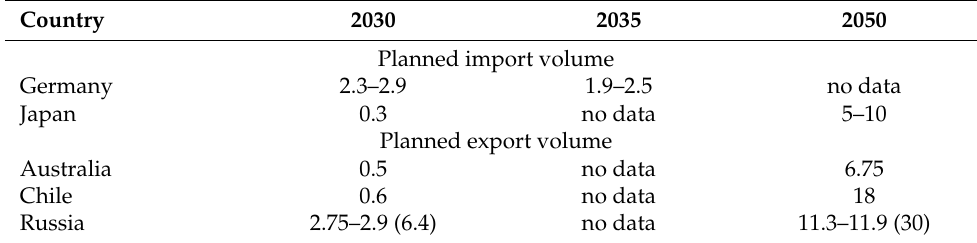
Table 4. Planned volumes of imports and exports of hydrogen according to the hydrogen strategies and road maps of countries, million tons [64]. Country 2030 Planned import volume